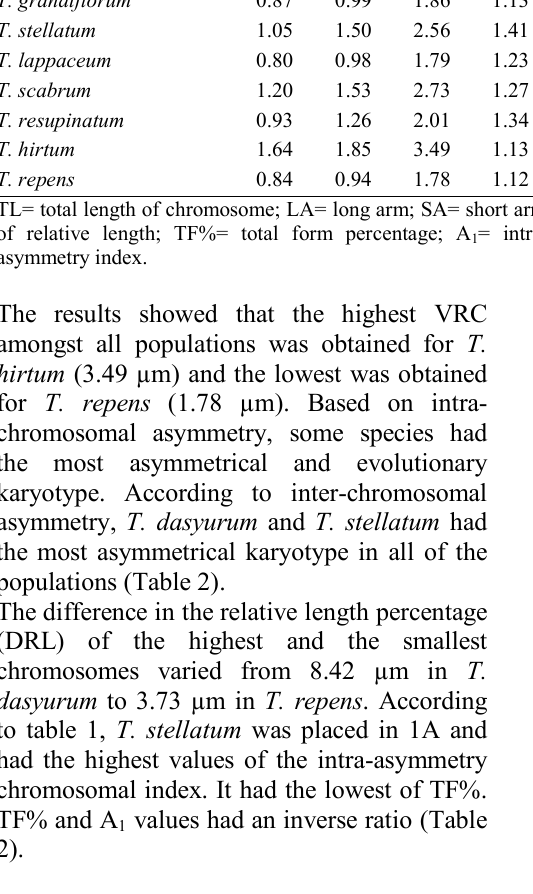
Table 3. Mean of chromosomes analysis of Trifolium species Populations SA LA TL AR CI